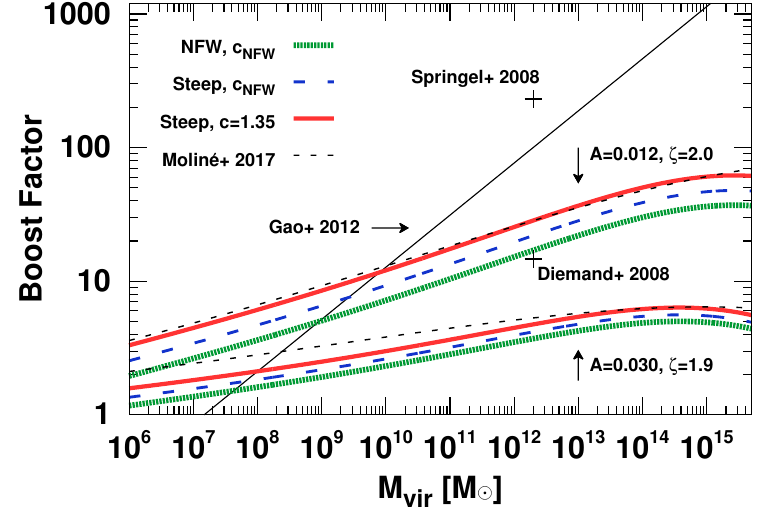
Figure 3. Boost factor as a function of halo virial mass. The data used in six thick curves are taken from Ishiyama [45]. Two subhalo mass functions, dn / dm = A / M vir ( m / M vir ) − ξ , are used ( A = 0.012, ξ = 2.0, and A = 0.030, ξ = 1.9 [44,48]). Thick dotted curves are for the NFW profile, where the empirical concentration-mass relation of field halos [44] are assumed for the full hierarchy of subhalos. Including the effect of steeper cusp of halos near the free streaming scale gives thick dashed curves. Besides, thick solid curves are results of incorporating the concentration of these halos derived from cosmological simulations [45]. For comparison, boost factors obtained in other studies are shown with thin dashed curves [48] (two subhalo mass functions are used), thin solid curves [41], and crosses